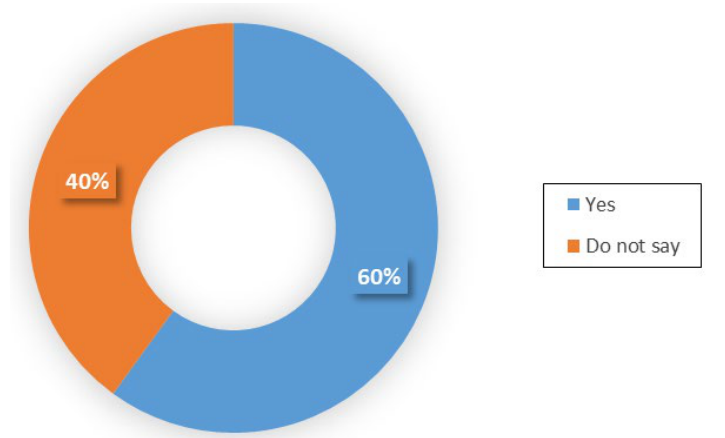
Figure 2. GDPR compliance